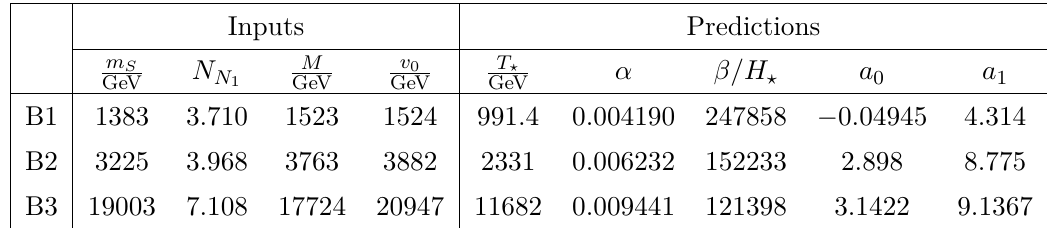
Table 2 . Values of the parameters corresponding to the three benchmark (starred) points in the left panel of figure 3 and with GW spectra shown in the right panel of the same figure.